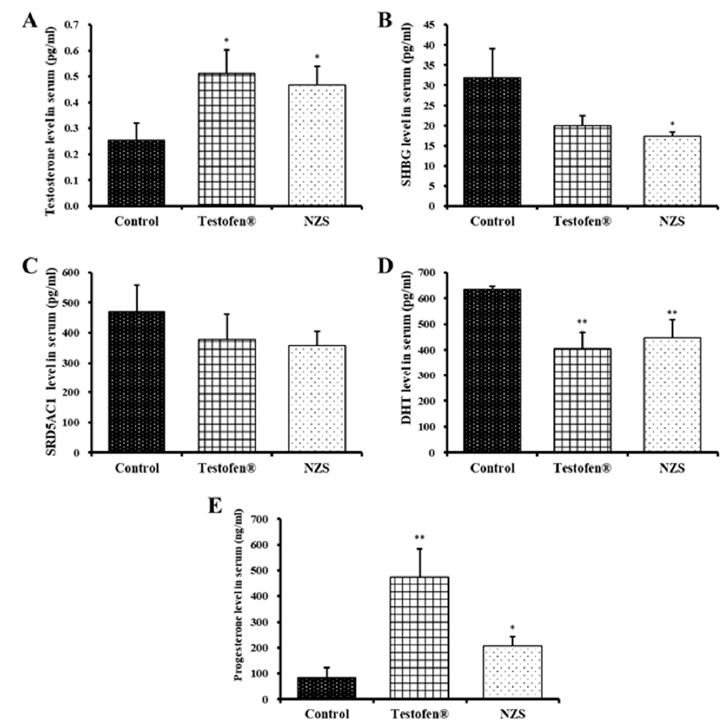
Figure 3. Comparative analysis of serum levels of testosterone ( A ), sex hormone-binding globulin (SHBG) ( B ), steroid 5 alpha-reductase 1 (SRD5A1) ( C ), dihydrotestosterone (DHT) ( D ), and progesterone ( E ) after NZS extract administration for four weeks. Data are expressed as means ± standard error (n = 5). Symbols of * and ** denote significant differences compared to aged rat (control) at p <0.05 and p < 0.01 levels, respectively.